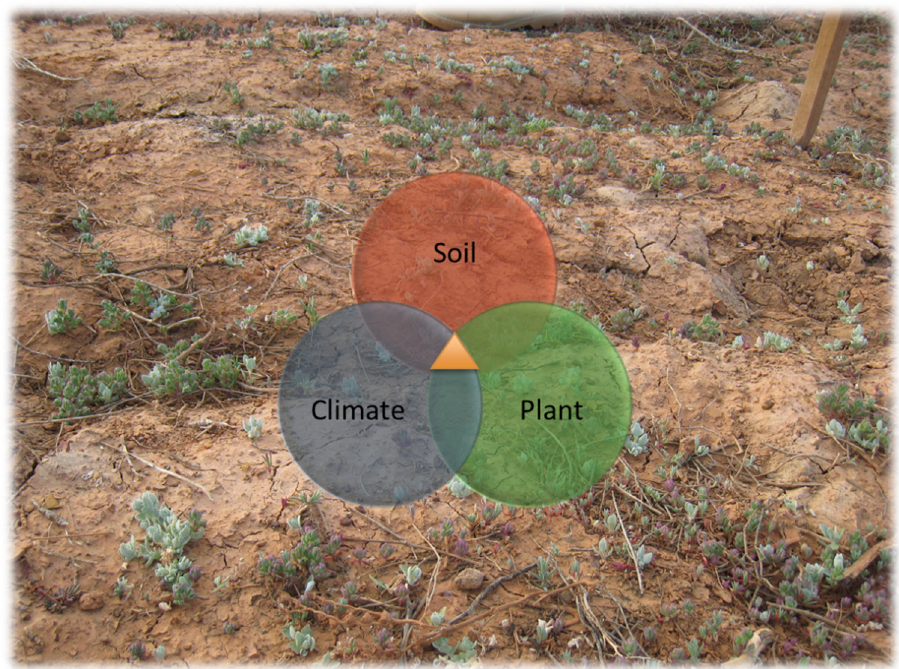
Figure A1. The figure indicating the overlap (small triangle) of soil, plant and climate, which is required knowledge for selection of an effective remediation technique for successful reclamation.